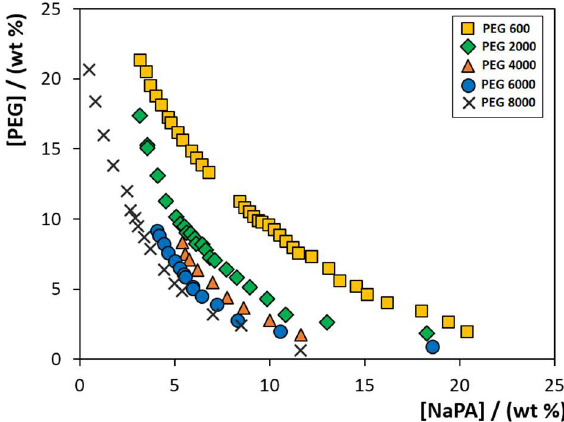
Figure 1. Solubility/binodal curves for ABS composed of PEG (different MW), NaPA 8000 + 5 wt% of [Ch]Cl, at 300.15 K: ( ) PEG 600; ( ) PEG 2000; ( ) PEG 4000; ( ) PEG 6000; and ( ) PEG 8000. Data corresponding to the latter system were taken from the literature [22].